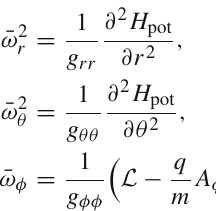
Fig. 5 Plot showing the ISCO radius as a function of B in the case with both neutral and charged particles